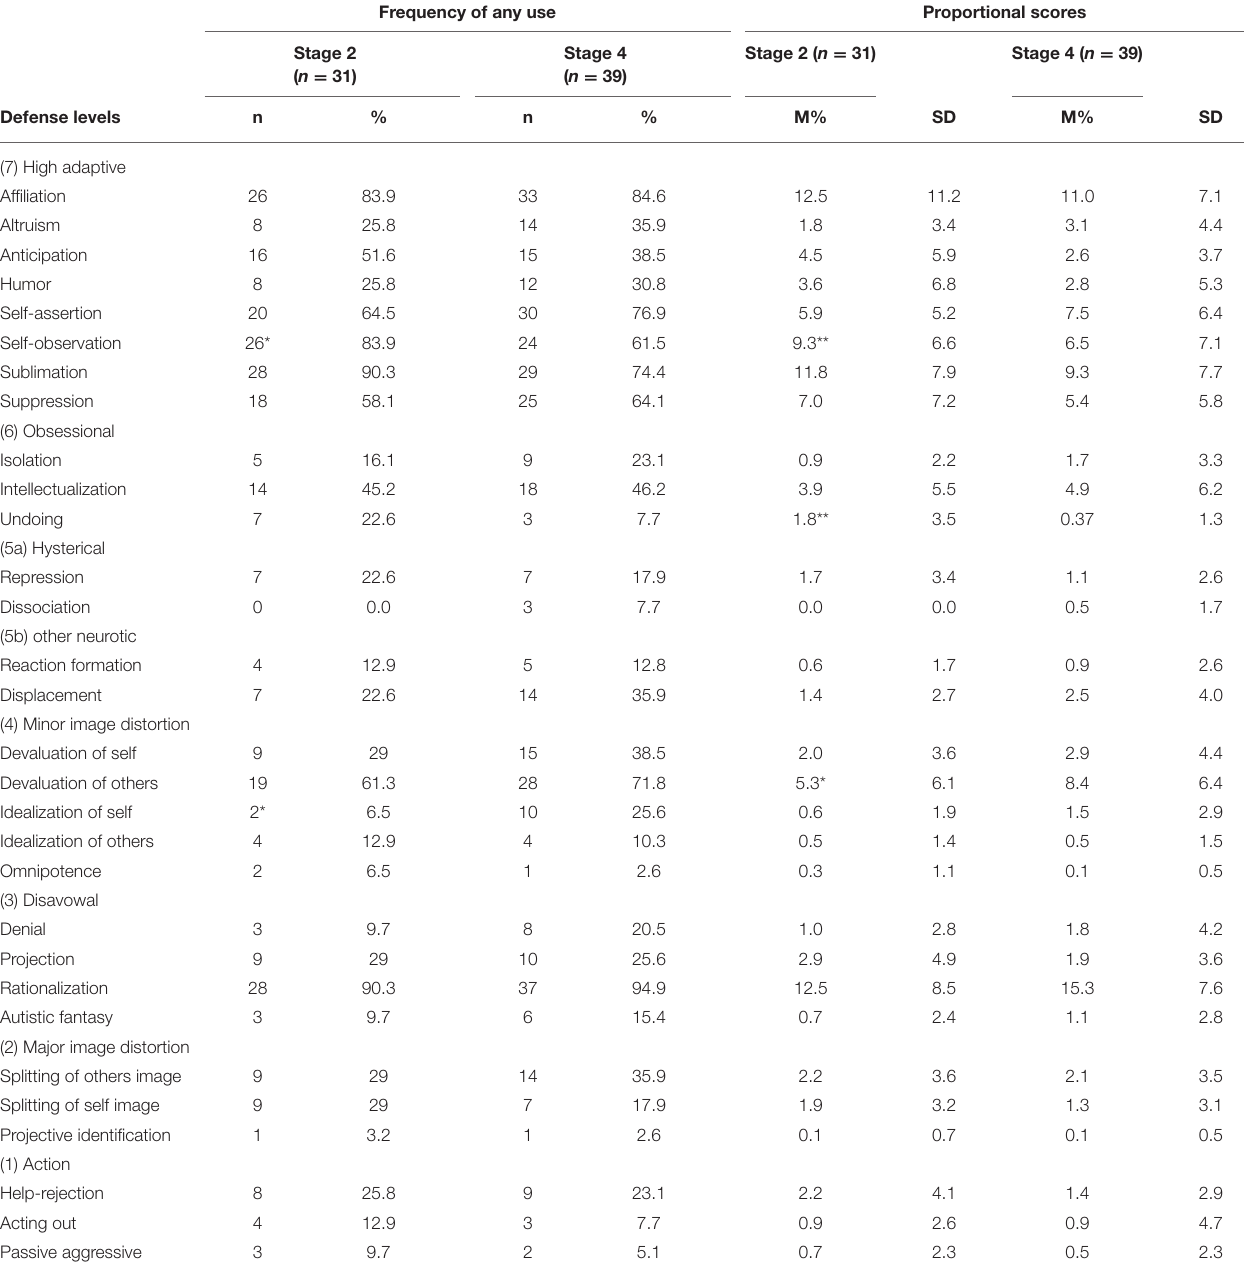
TABLE 3 | Prevalence of individual defenses between women patients with stages 2 and 4 BC. Frequency of any use Proportional scores Stage 2 Stage 4 Stage 2 ( n = 31) Stage 4 ( n = ( n = 31) ( n = 39)